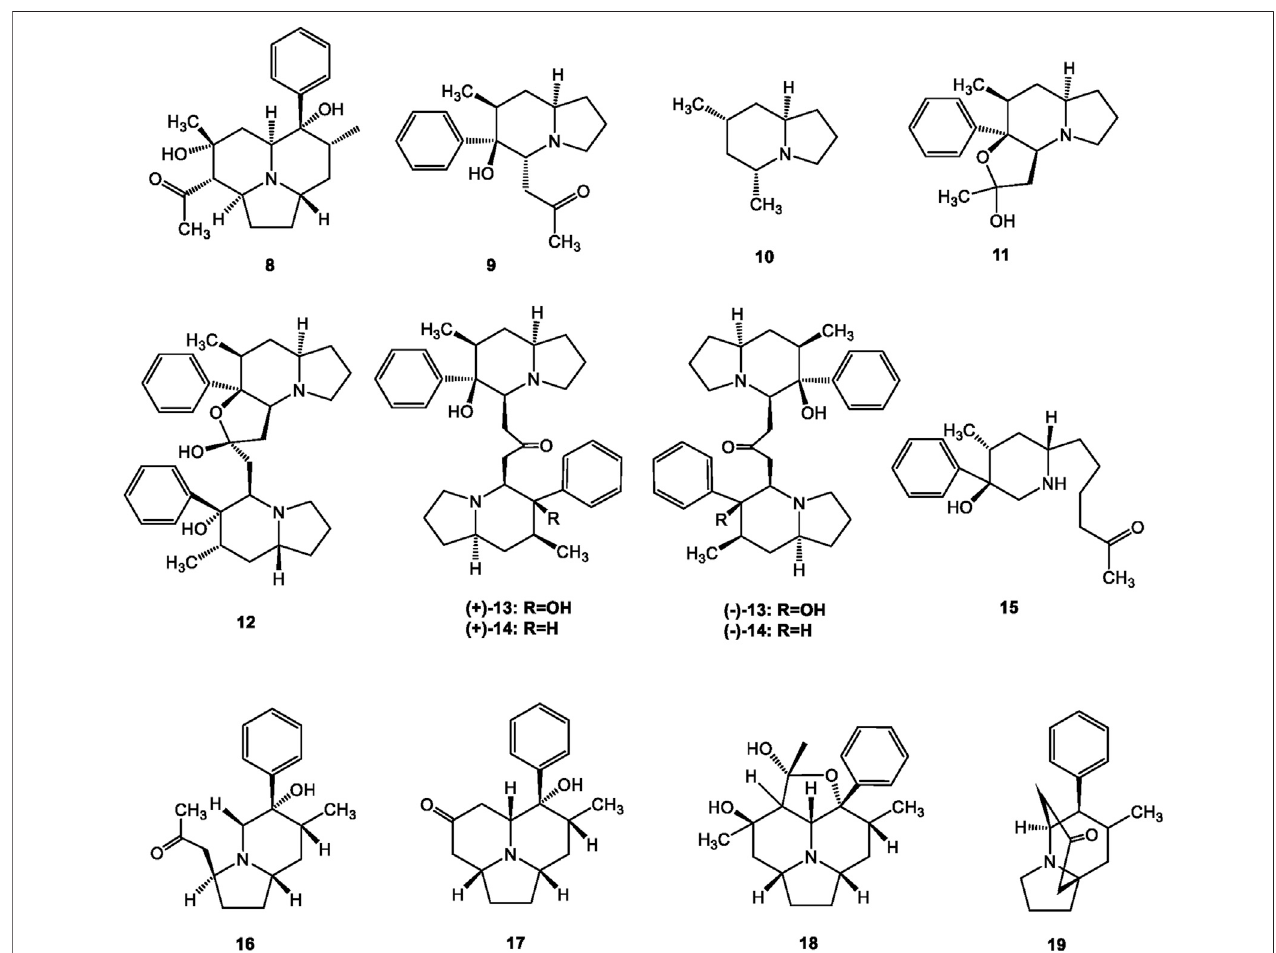
FIGURE 2 | Structures of indolizidine alkaloids reported in Dendrobium